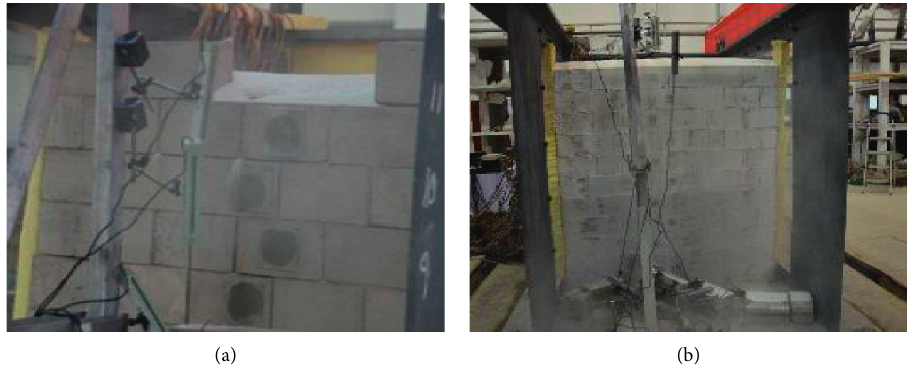
Figure 8: Seismic damage to RSRW. (a) Specimen 1 damage. (b) Specimen 2 damage.